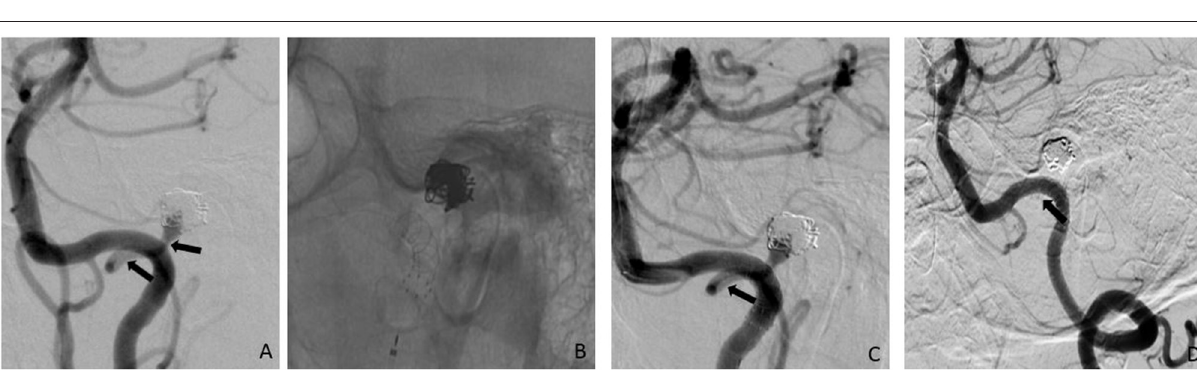
FIGURE 1 | (A) Posterior-anterior view after injection of the left VA showing a 2mm aneurysm of the left SCA; (B) successful implantation of a p64 3/12mm from the left PCA to the BA; (C) final run after the FD implantation showed already reduction of the perfusion (arrow); (D) 3 rd FU after 20 months shows aneurysm unchanged as well as a significant caliber reduction of the right P1- segment. (E) a second FD- p64 3/9 mm- was implanted coaxial with the first FD without any complications. (F) FU after 12 months after the second confirms that the aneurysm has shrunken, but remains still patent. The left SCA shows significant reduction in size (arrowhead) but is also still patent. The right P1 segment (asterisk) is reduced in caliber now.